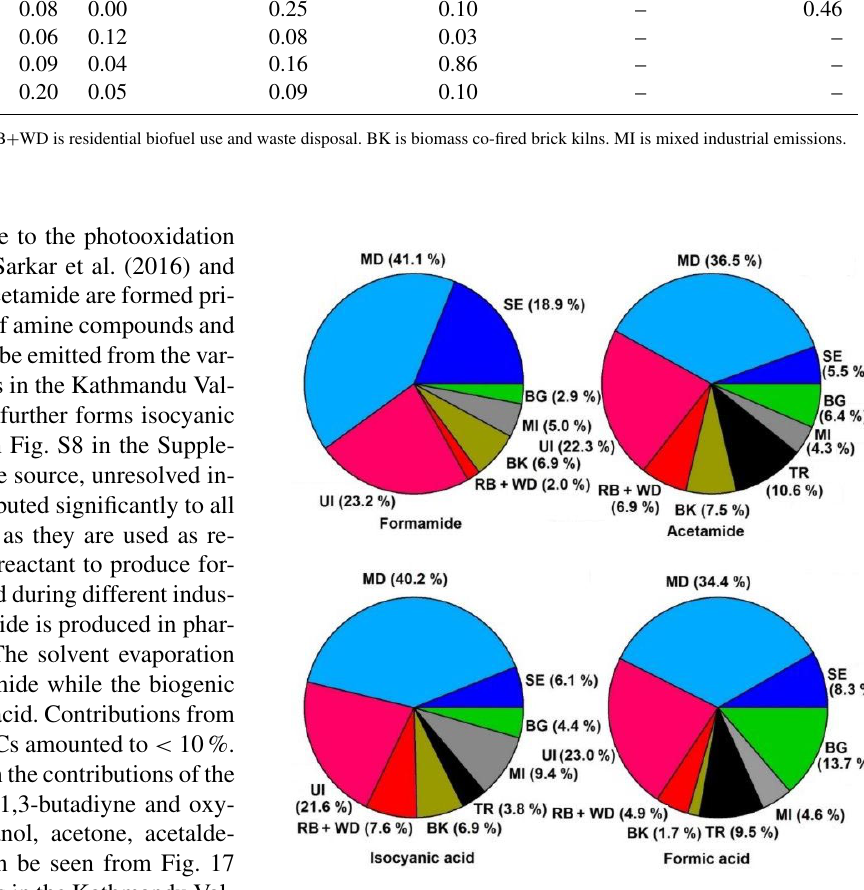
Figure 16. Contribution of PMF-derived sources to formamide, ac- etamide, isocyanic acid and formic acid. Source names are abbrevi- ated as follows: MD is mixed daytime, MI is mixed industrial, UI is unresolved industrial, BK is brick kiln, TR is traffic, RB + WD is residential burning and waste disposal, SE is solvent evaporation, and BG is